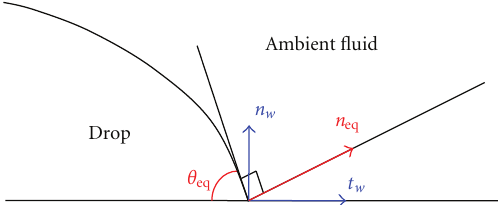
Figure 3: Modification of the normal vector at the contact